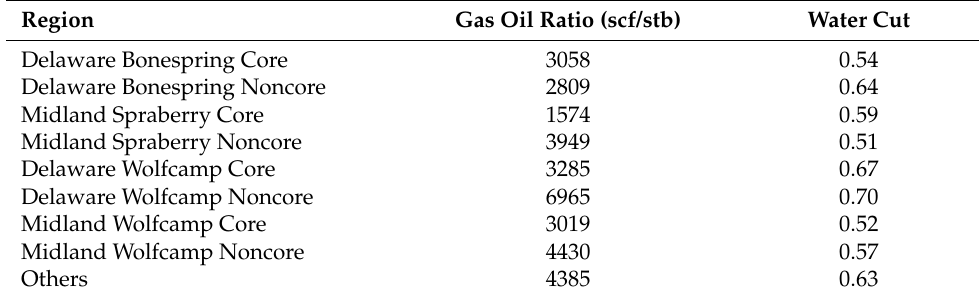
Table 2. Summary of GEV-mean GOR and GEV-mean Watercut for each Permian region. Region Delaware Bonespring